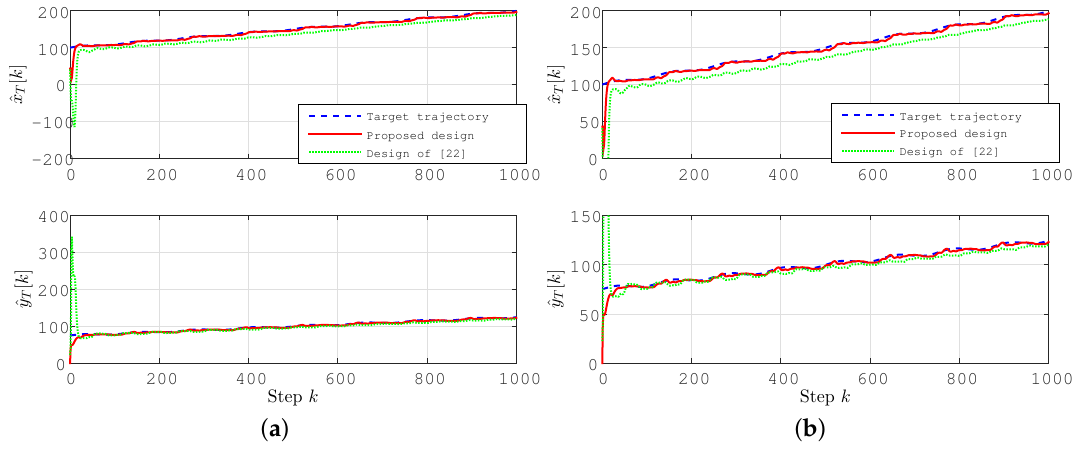
Figure 7. Location estimate ˆ p T [ k ] for the drifting target case. ( b ) The scaled version of ( a ) to provide the details of the convergence characteristics for the proposed scheme.